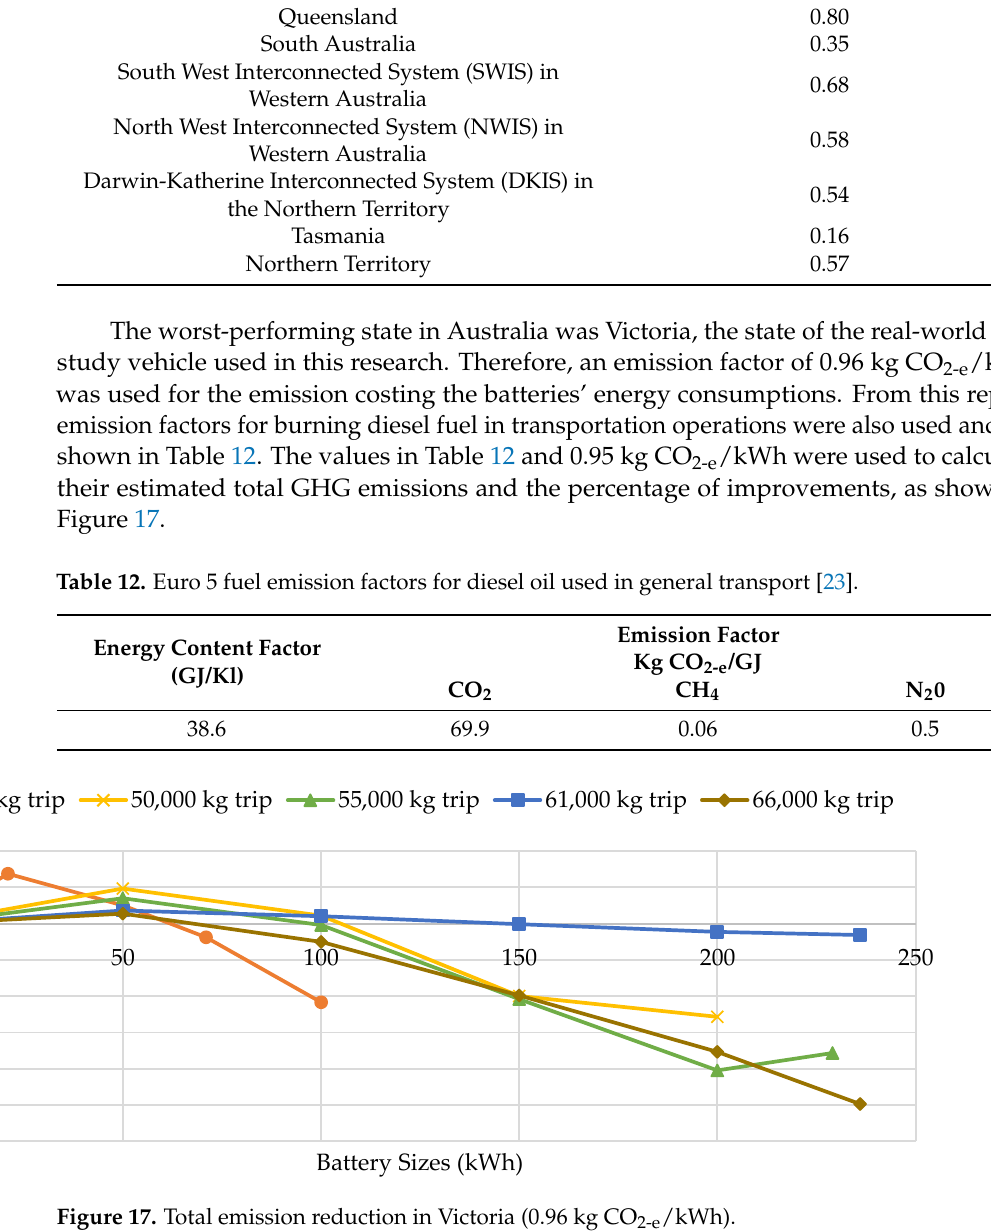
Table 11. Emission factors for consumption of purchased electricity or loss of electricity from the grid [23].